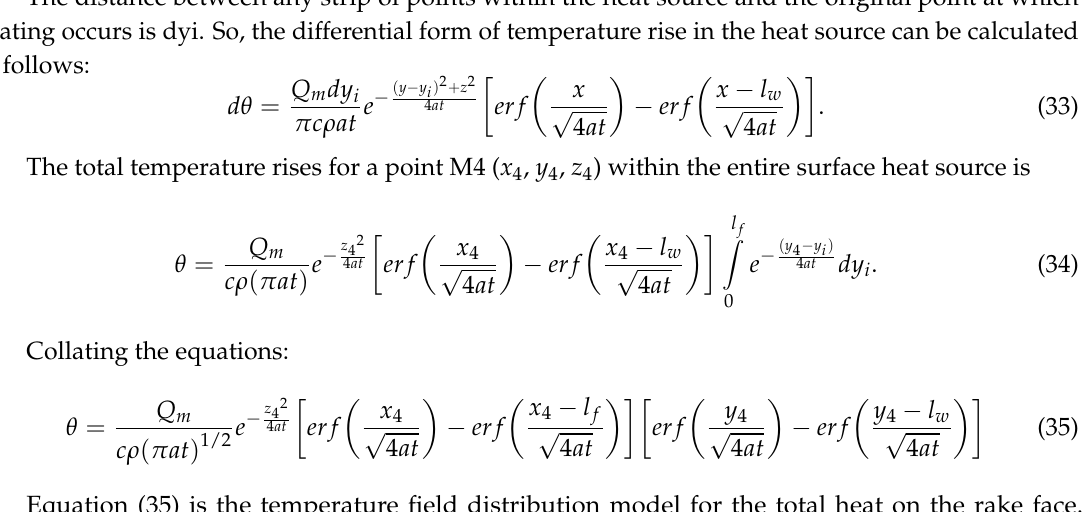
Figure 7. Schematic diagram of the surface heat Figure 7 . Schematic diagram of the surface heat source.